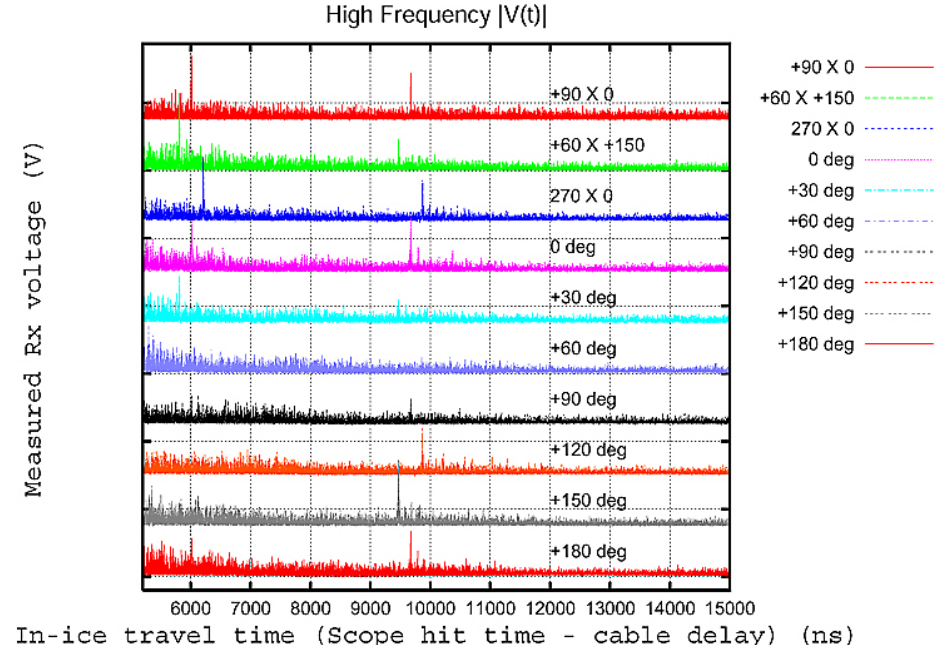
Fig. 11. Voltage magnitude after applying a 500MHz high-pass filter to the data shown in Fig. 3. Vertical divisions correspond to 0.2mV.